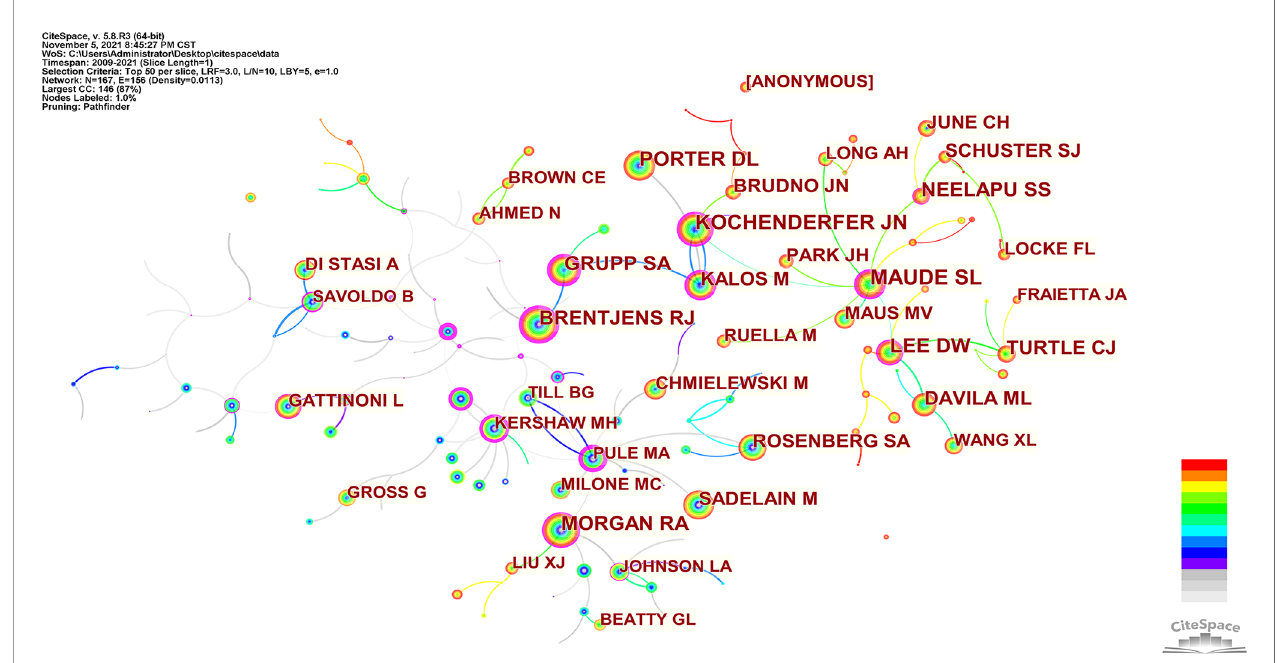
FIGURE 6 | CiteSpace visualization map of co-cited authors involved in CAR-T cells.